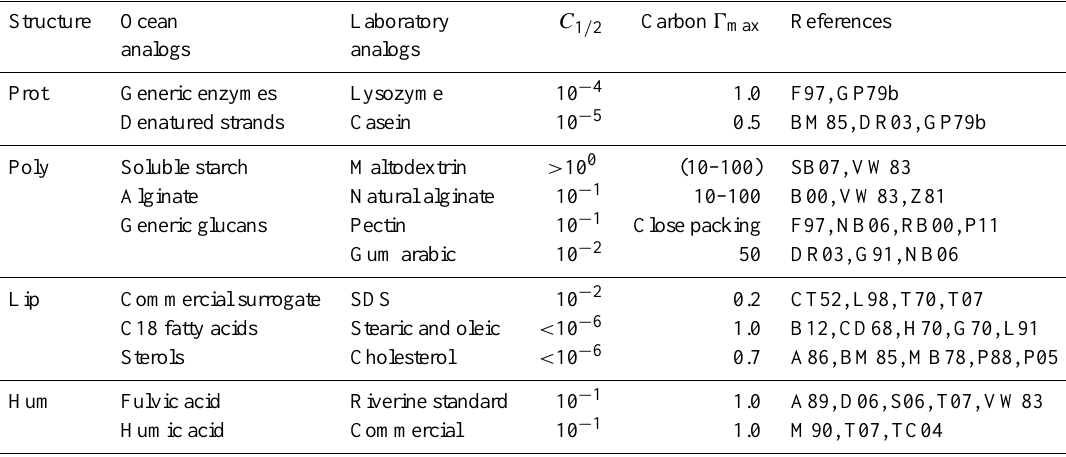
General abbreviations: BSA – bovine serum albumin, SDS – sodium dodecyl sulfate. Reference abbreviations: A86 – Alexander et al. (1986); A89 – Averett et al. (1989); B00 – Babak et al. (2000); B12 – Brzozowska et al. (2012); BM85 – Barger and Means (1985); CD68 – Christodoulou and